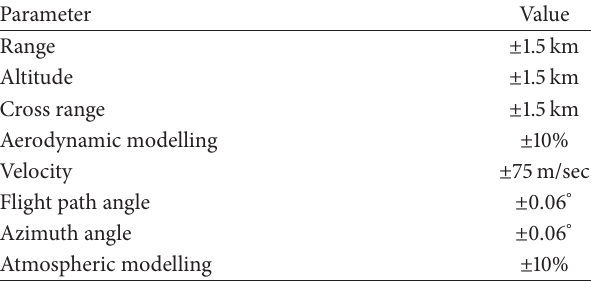
Table 2: The perturbations in Monte Carlo run.